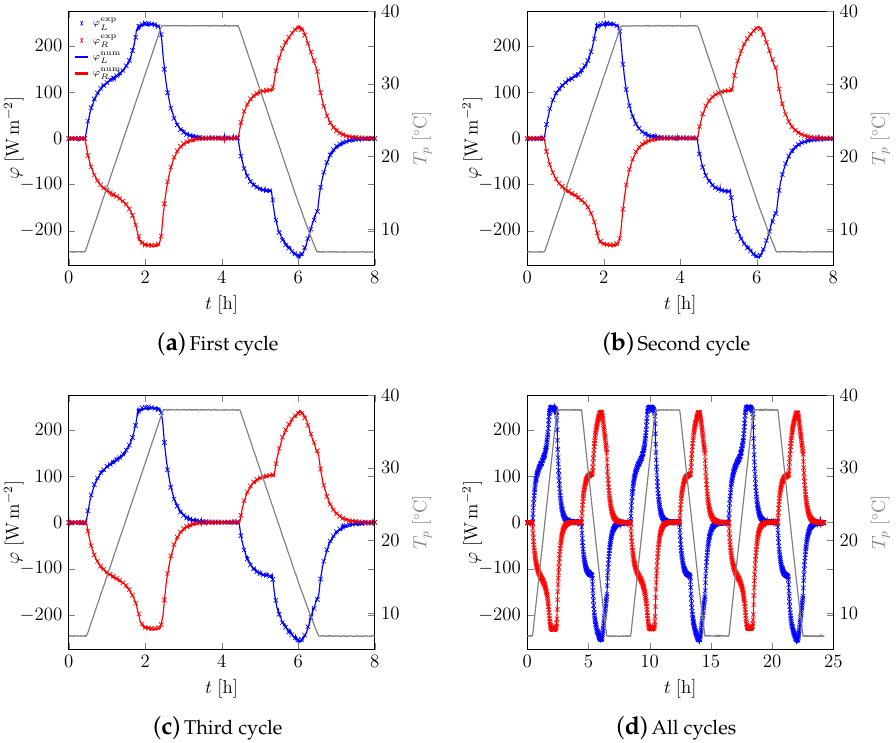
Figure A8. 22.1% w -PCM mortar: comparisons of the experimental fluxes with the numerical ones after identification for the 2 h heating/cooling ramp experiment.